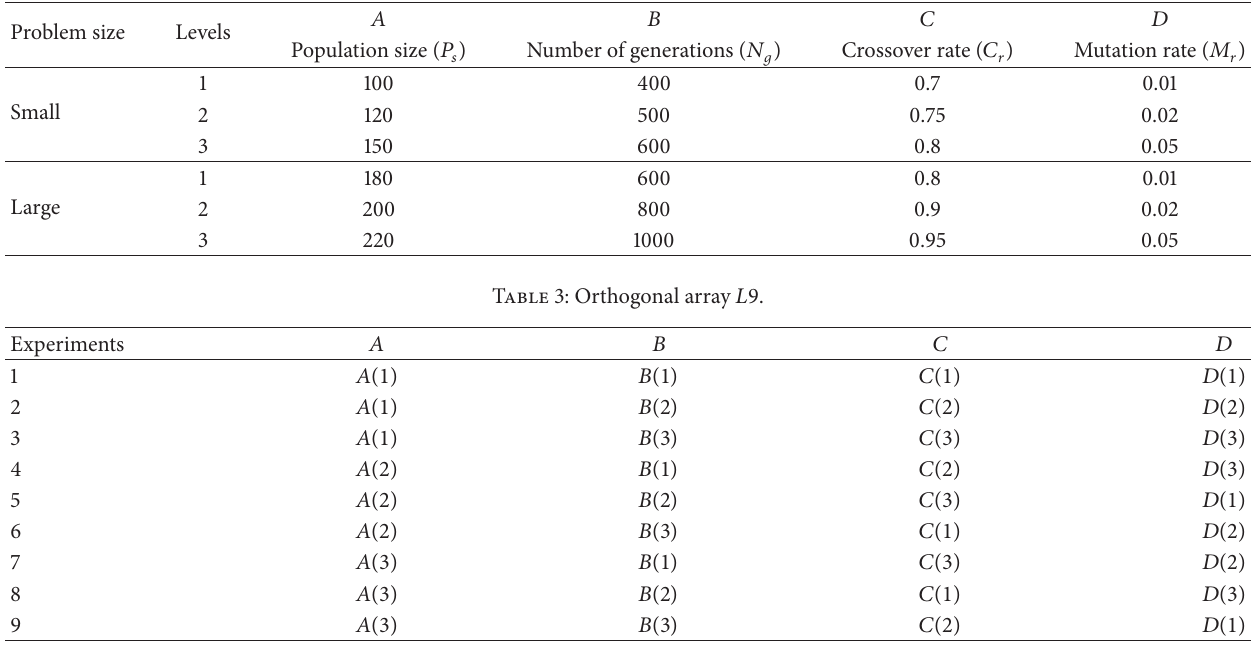
Table 2: Genetic algorithm parameters and their levels.